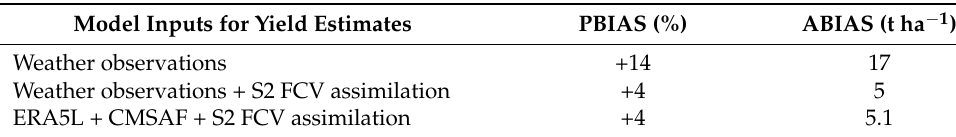
Table 7. Performance of the proposed model using different model inputs for yield estimation compared with the actual observed final